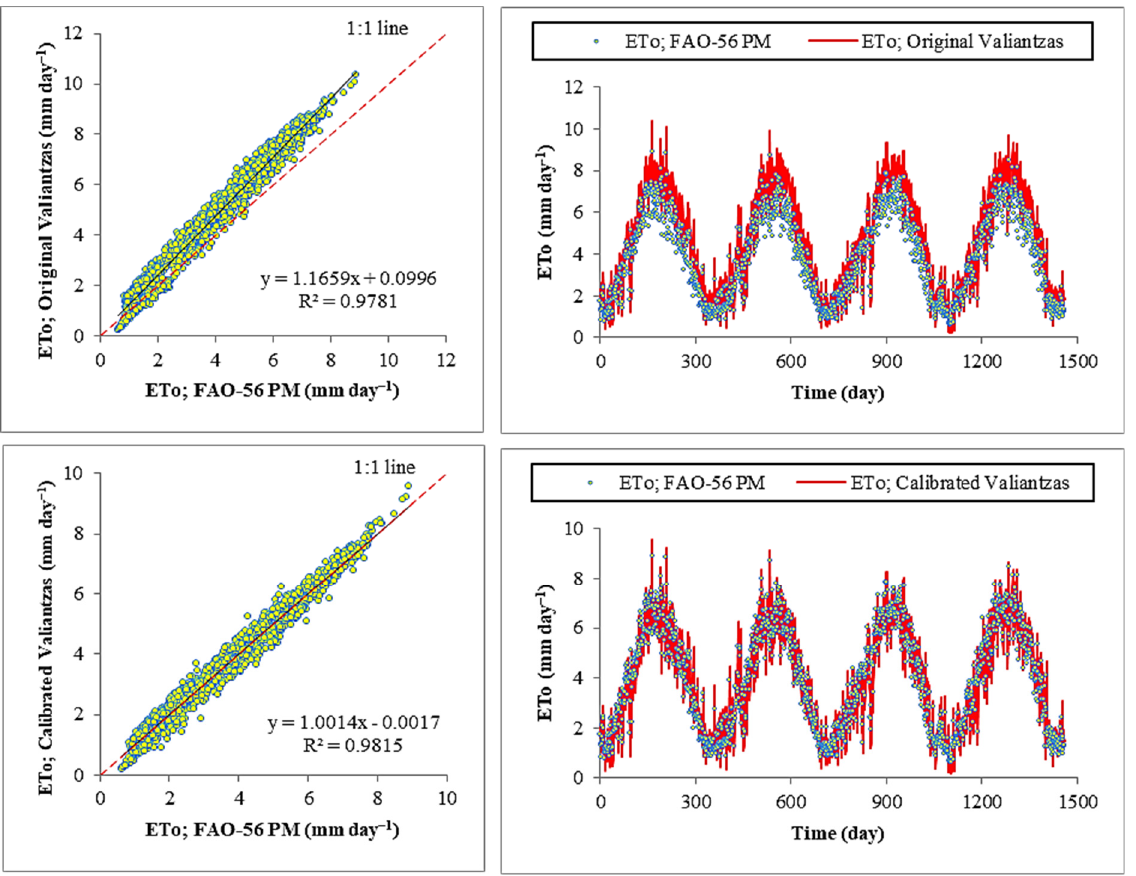
Figure 8. Scatter and time series plots of the daily values of FAO-56 PM ETo vs. modeled data by the original and calibrated forms of Valiantzas equation during the test phase (Shiraz station).